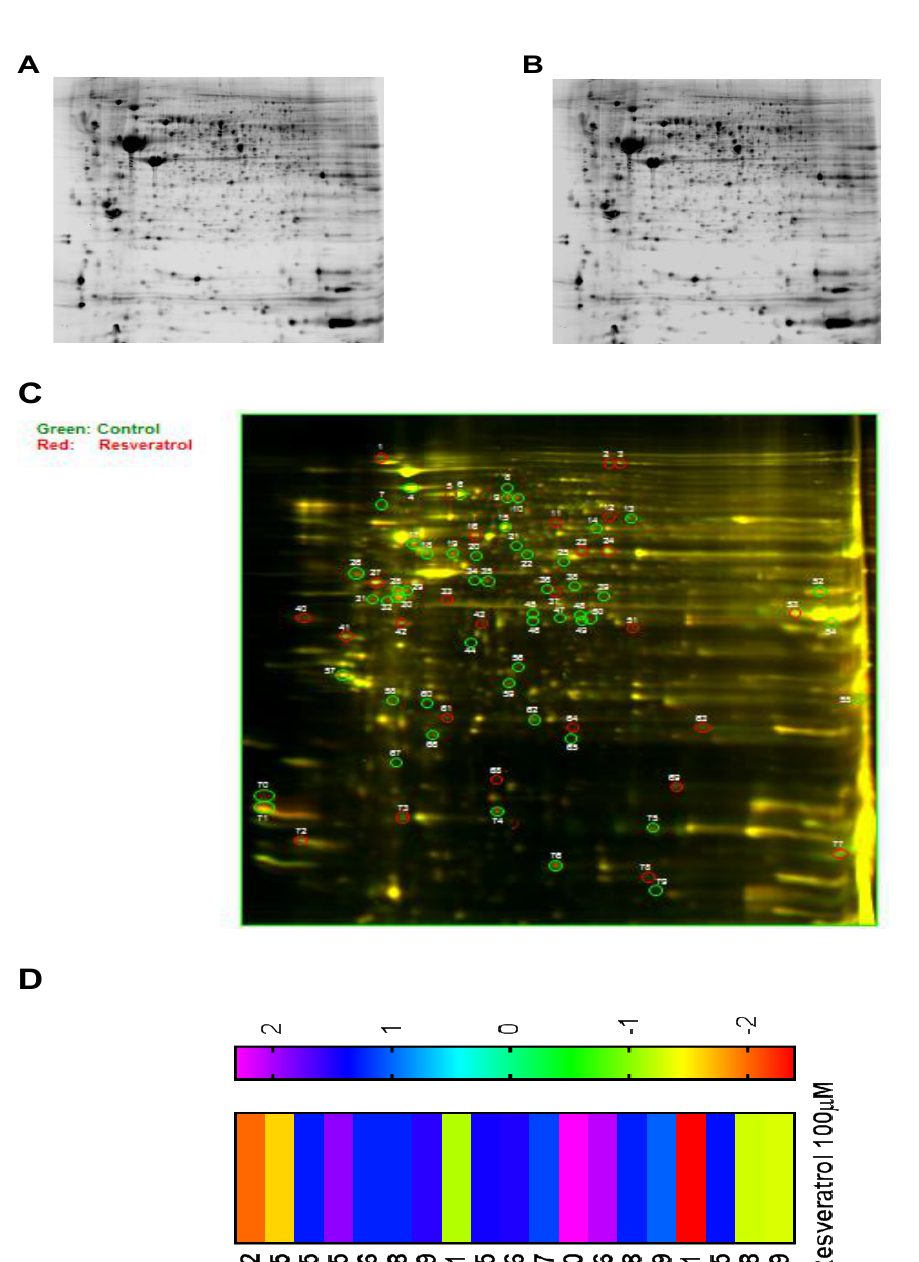
Figure 6. Proteomic analysis of esophageal adenocarcinoma cells (OE33, OE19 and FLO-1 cells) on treatment with resveratrol. OE33 cells were treated with the IC 50 concentration (100 µ M) of resveratrol. Representative 2D gel image of the control ( A ) and the treated sample ( B ) is shown. Cell lysates of the control group were combined with Cy3 dye and the treated group with Cy5 dye. Overlay of the two gels on isoelectric focusing (IEF) is shown ( C ). Differentially expressed proteins on the gel are circled. ( D ) Heatmap showing the fold change in the expression of the identified proteins in treated sample on comparing to the control sample. Similar proteomic analysis was performed with OE19 and FLO-1 cells on treatment with resveratrol at the IC 50 concentration of 50 µ M and 40 µ M, respectively. The raw datasets from cell line OE19 and FLO-1 are provided in the Supplemental Material Figure S1. Spots common to all the three cell lines were picked and analyzed. The details of the molecules profiled with Fold Changes are represented in Table